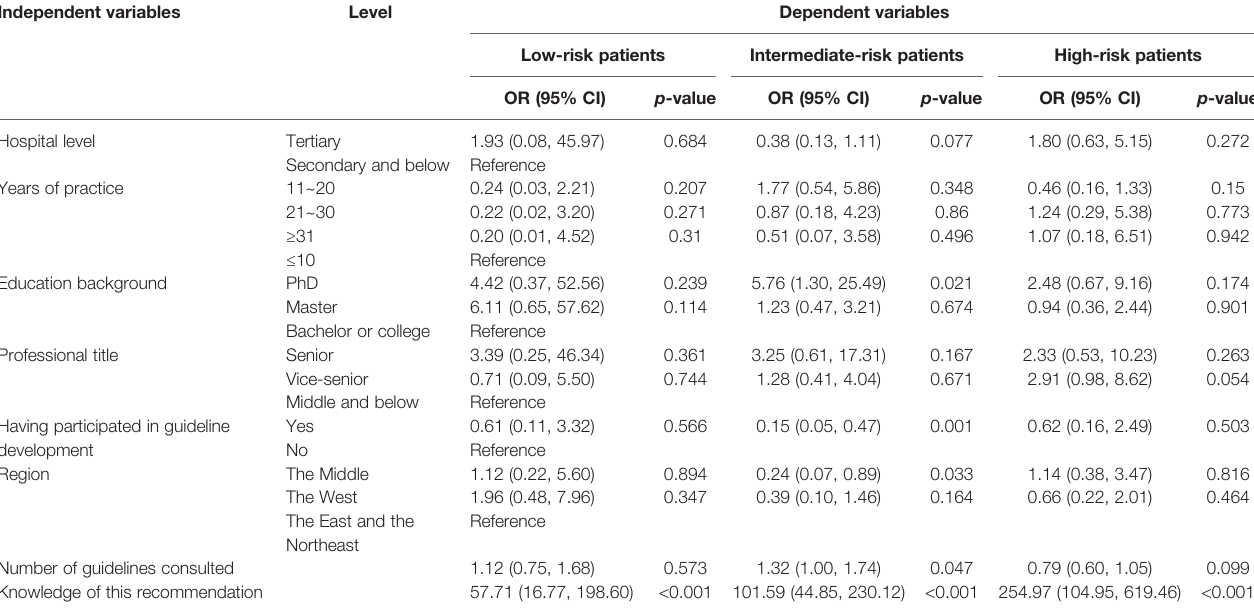
TABLE 4 | Multivariable logistic regression of compliance with recommendation about